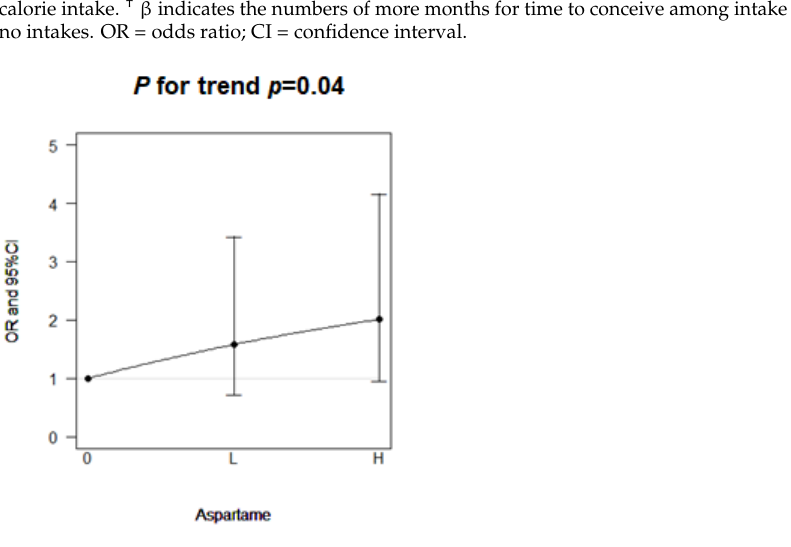
Figure 1. Dose–response effect of aspartame consumption on the risk of infertility in young women (age ≤ 35 years). Table 2. Association of aspartame consumption with the risk of infertility, TMINC (n = 845).